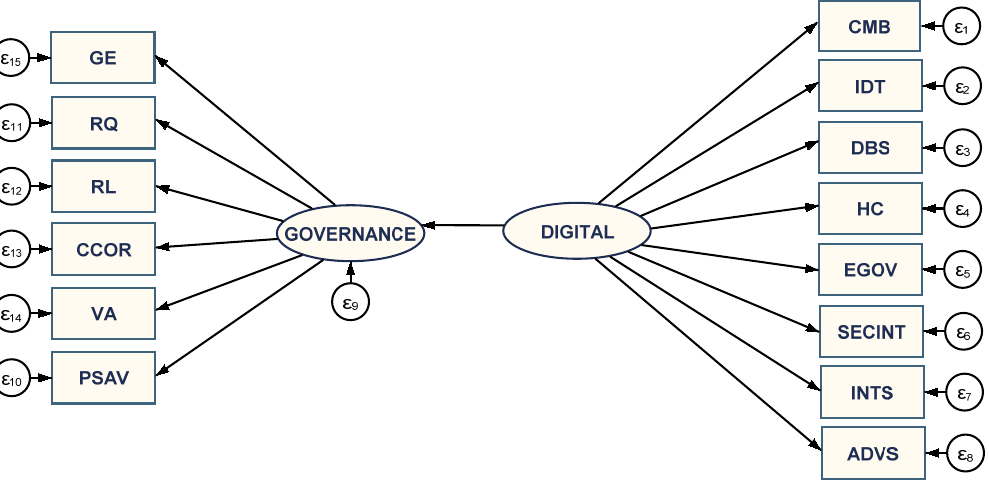
Figure 3. Configuration of the SEM model designed to assess the interplay between digitalisation and public governance. Source: Authors’ research in